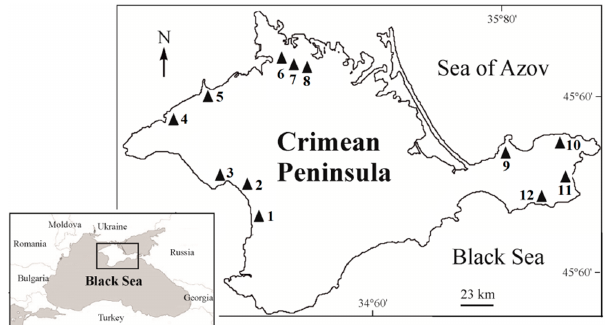
Figure 1. Distribution of the studied saline lakes in the Crimea: 1 — Kyzyl-Yar, 2 — Sasyk-Sivash, 3 — Moynakskoye, 4 — Dzharylgach, 5 — Bakalskoye, 6 — Krasnoye, 7 — Kiyatskoye, 8 — Kirleutskoye,